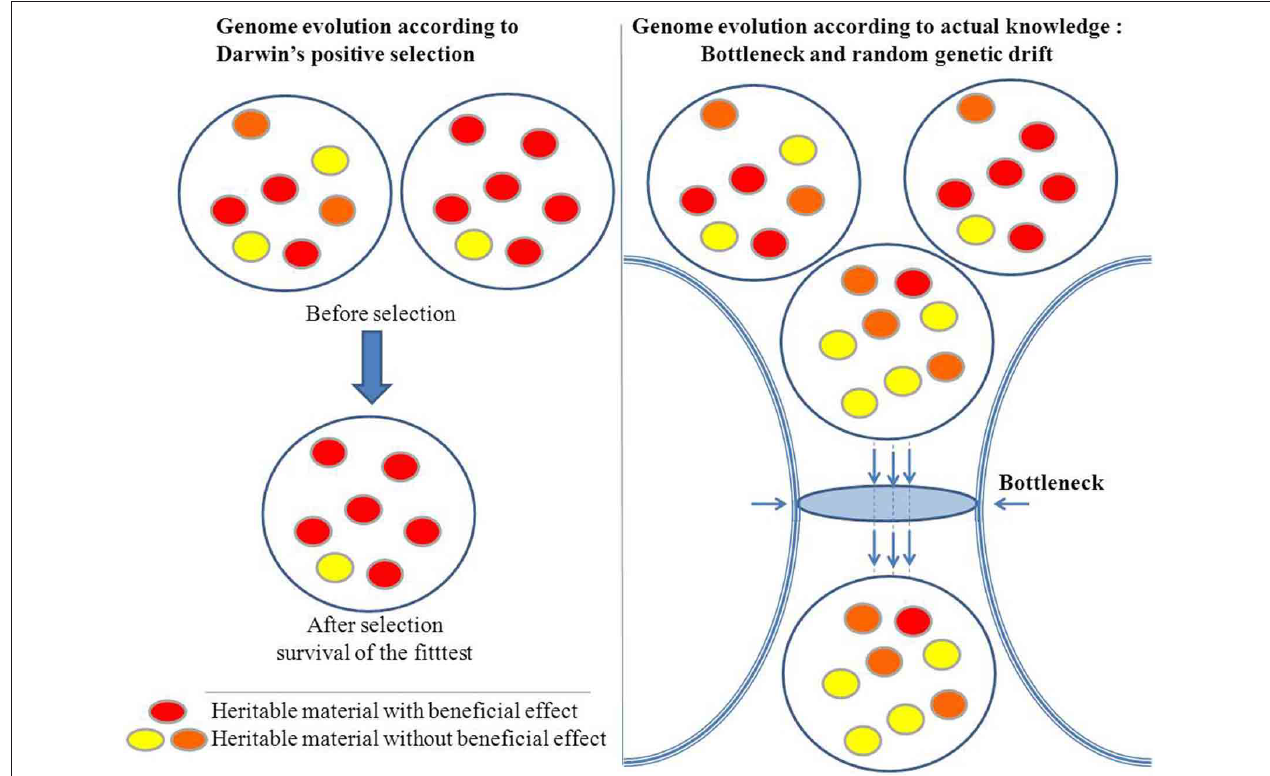
FIGURE 1 | Natural selection versus stochastic